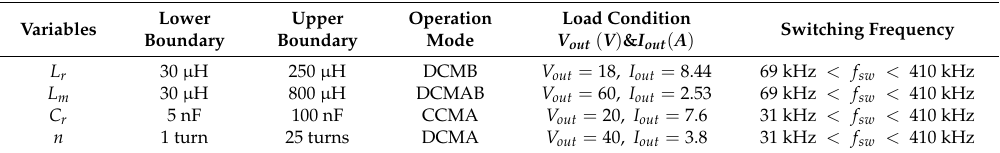
Table 3. Load condition, constraints and switching frequency